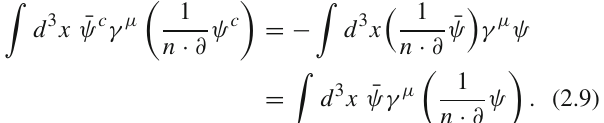
Fig. 2 Relevant graphs for the induced AA